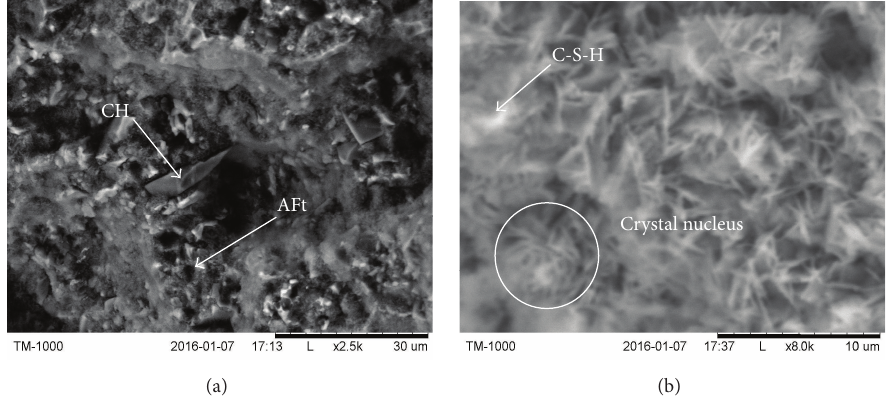
Figure 13: SEM of cement paste (a) without NS and (b) with NS30/4.0 at 1 day.